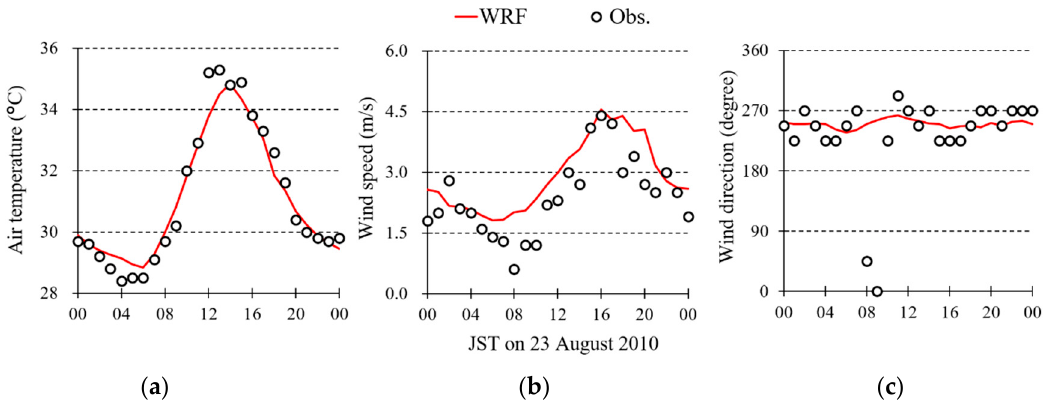
Figure 3. Diurnal variations of Weather Research and Forecasting model (WRF)-simulated and observed ( a ) air temperature; ( b ) wind speed; ( c ) wind direction at the Osaka Meteorological Observatory on 23 August 2010.